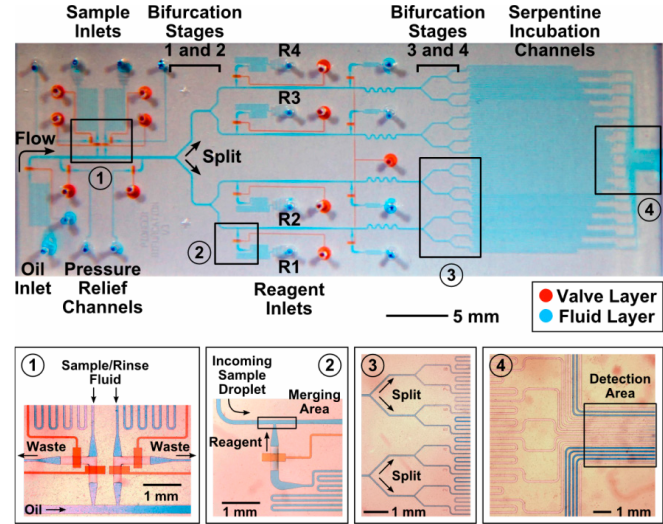
Figure 2. Parallelized Combinatorial Droplet Device. The microfluidic device employs a two-layer architecture where the flow of oil, sample droplets, and reagent droplets in the fluid layer (blue) is regulated by designated valves in the valve layer (red). The most upstream inlet is reserved for the carrier oil, which drives droplet formation and flow. Downstream to the oil inlet are two sample inlets with corresponding rinsing channels (insert micrograph 1) connected to the fluid channel. The fluid channel splits into two identical halves at a bifurcating Y-junction and each of the four resulting fluid channels is connected with a reagent channel that is individually controlled by a microvalve for programmable reagent injection (R1–R4; insert micrograph 2). In our device, reagents can be